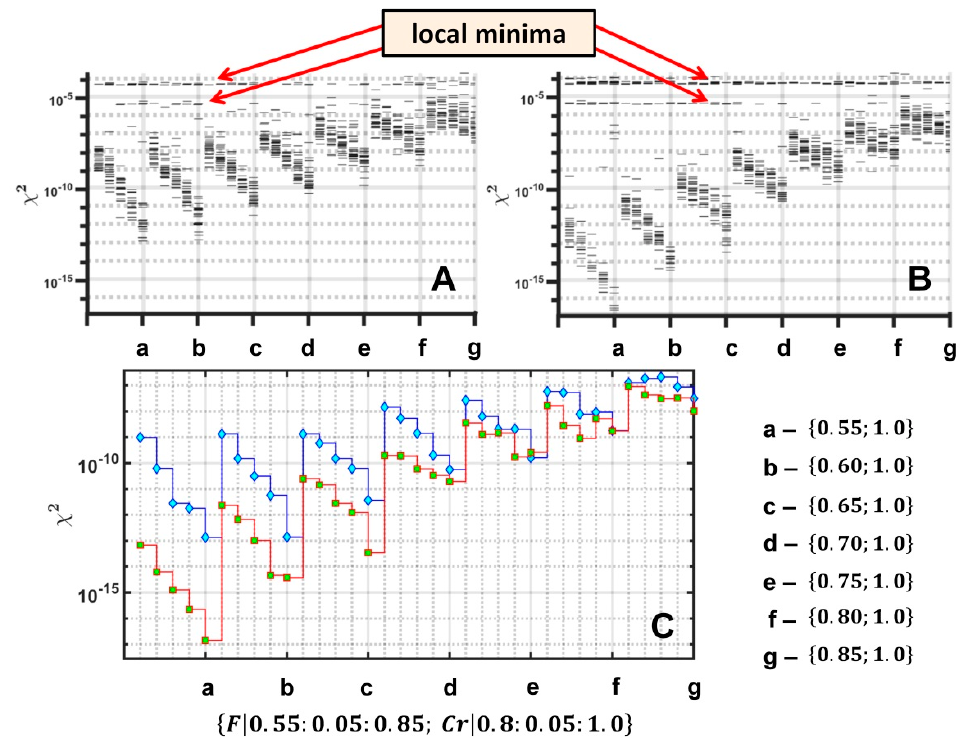
Figure 3. Strategy test. Distributions of the objective functions values obtained for DE/best/1/bin ( A ) and DE/rand-to-best/1/exp ( B ) strategies after 30 runs of DE for each { F , Cr } pair. Comparison of the best results for DE/best/1/bin (blue) and DE/rand-to-best/1/exp (red) are shown in plot ( C ). Latin letters correspond to { F , Cr } pairs. Red lines indicate the local minima of